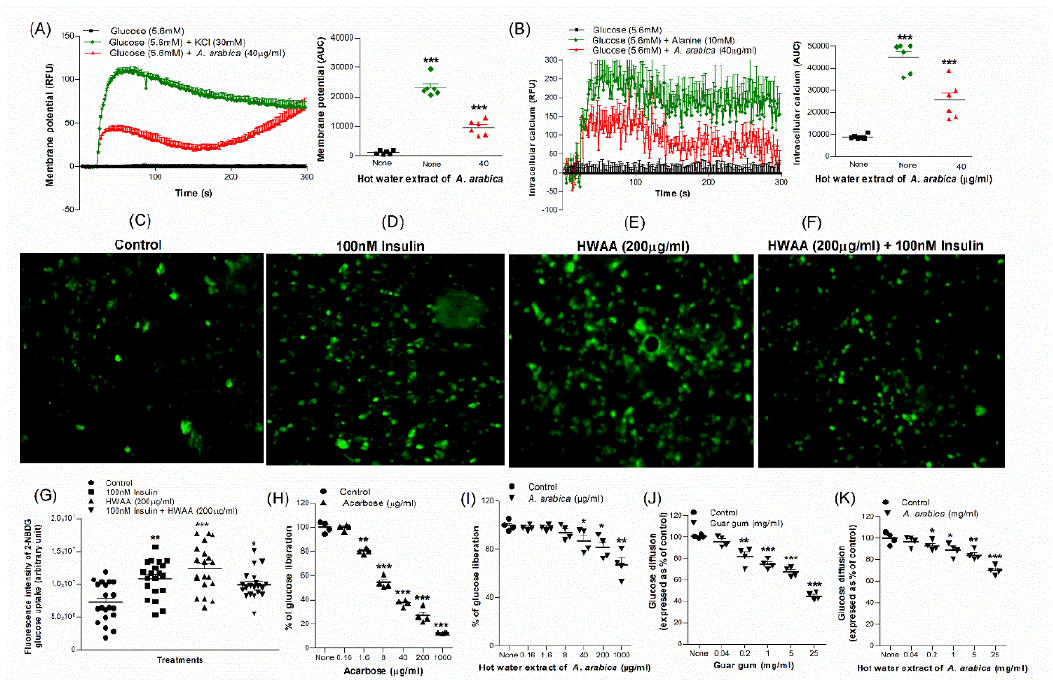
Figure 2. Effects of hot-water extract of A. arabica bark on ( A ) membrane potential and ( B ) intracellular calcium in BRIN BD11 cells, ( C – G ) glucose uptake in differentiated 3T3L1 adipocyte cells, ( H ) acarbose, ( I ) starch digestion, ( J ) guar gum and ( K ) glucose diffusion in vitro. Changes in fluorescence intensity in differentiated 3T3L1 adipocytes incubated with extract in the ( E ) absence or ( F ) presence of 100 nM insulin. Images were taken at 10× magnification. Values are the mean ± SEM for n = 6 for membrane potential and intracellular calcium and n = 4 (~20 values of fluorescence intensity per group for glucose uptake) for glucose uptake, starch digestion and glucose diffusion. * p < 0.05, ** p < 0.01 and *** p < 0.001 compared to